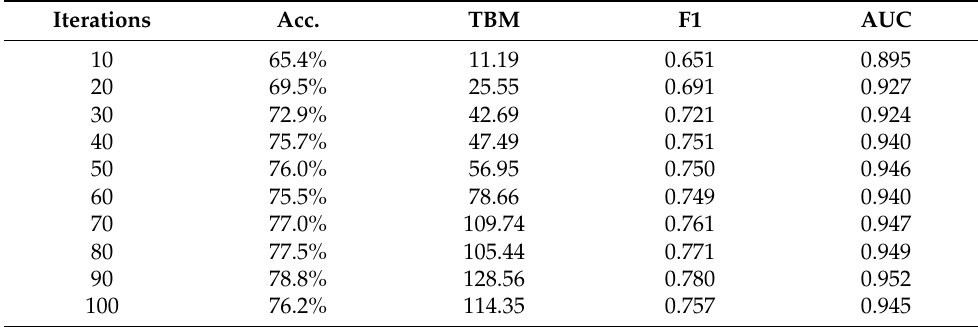
Table 14. Improving accuracy with Rotation Forest and C4.5 decision